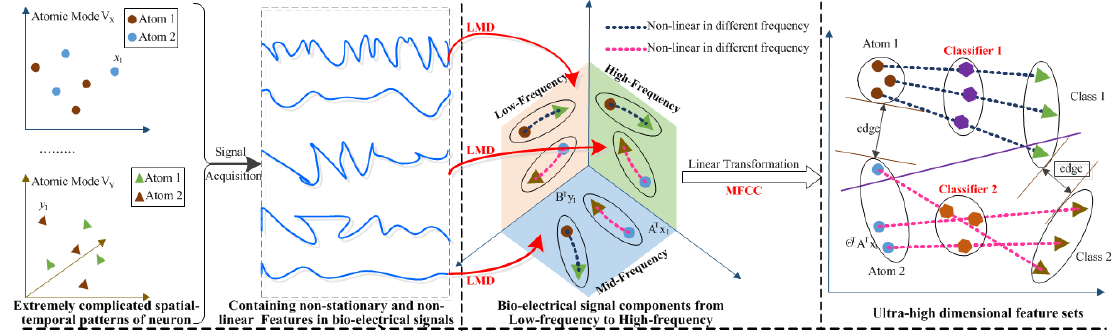
Figure 2. The architecture of the automated epileptic seizure detection